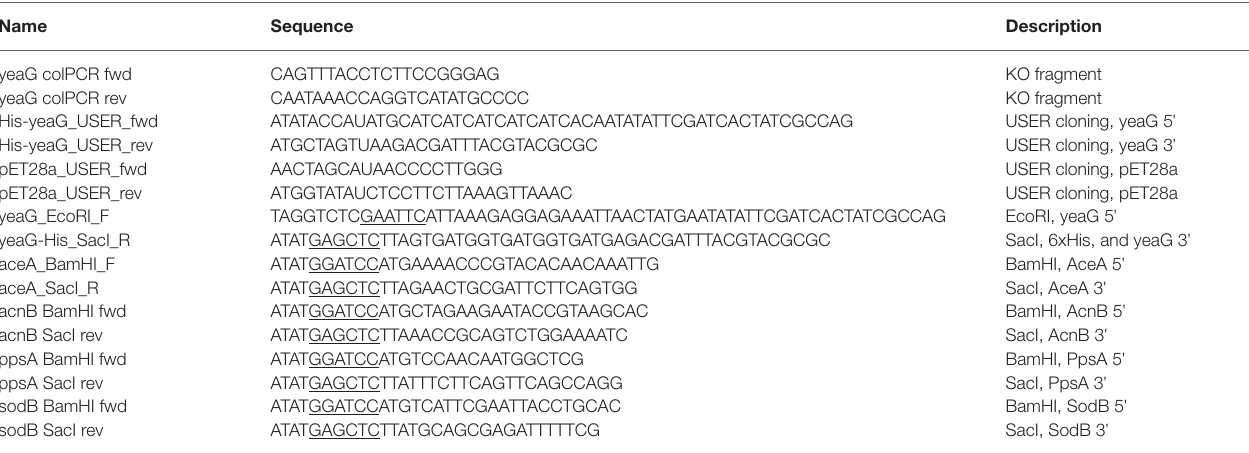
TABLE 1 | List of oligonucleotides used in this